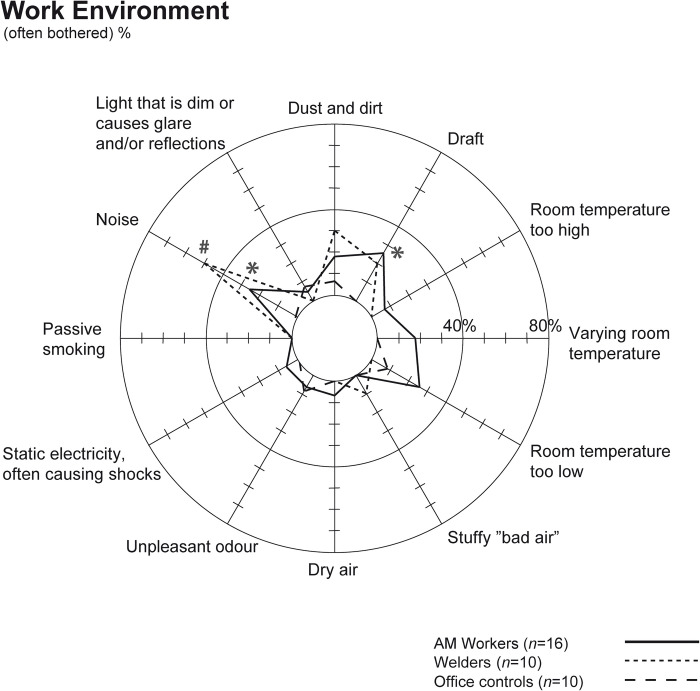
Summary of perceived indoor climate reported from work environment questionnaire, MM040NA.The diagram shows the prevalence of factors reported often (at least once a week) during the last 3 months. * p<0,05 AM vs Control, # p<0.05 Welder vs Control Chi-Square test.